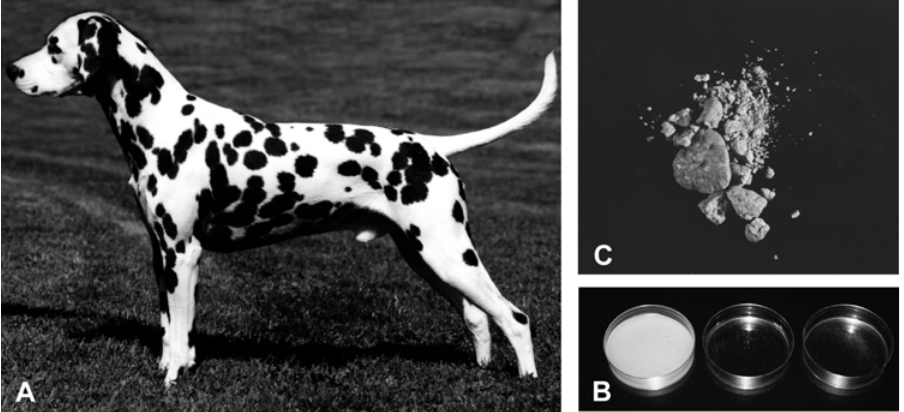
Figure 1. The Dalmatian phenotype. (A) The characteristic spotting pattern exhibited by the breed. (B) Urinary urate calculi removed from a Dalmatian. (C) Dalmatian urine crystallization: Dalmatian urine sample (left), urine from a heterozygous backcross dog (middle), and urine from a dog from an unaffected breed (right).